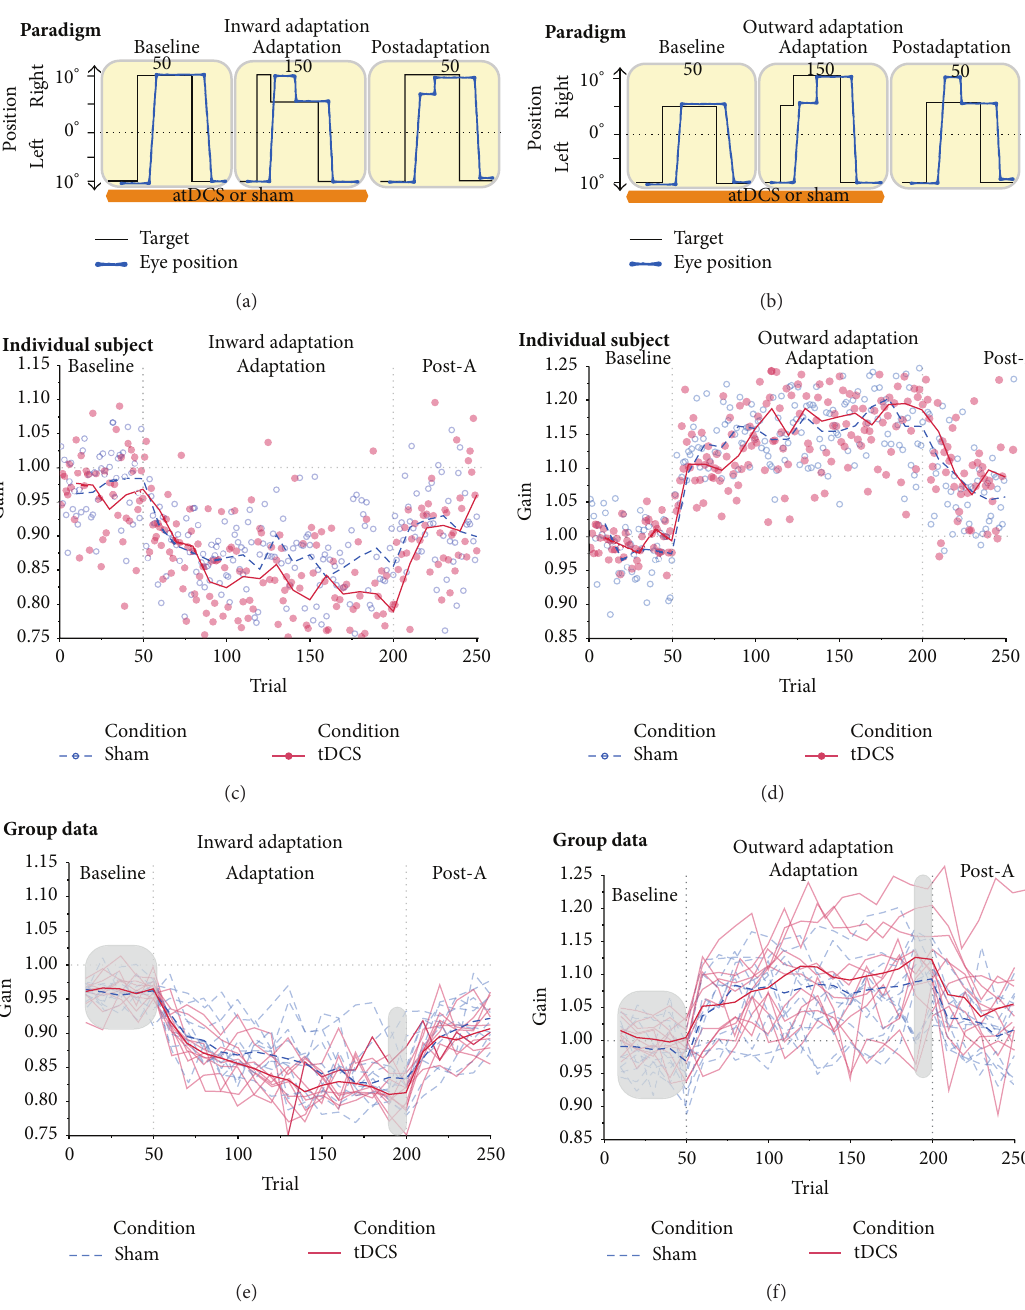
Figure 1: Experimental paradigms, single subject data, and population data. Panel (a) depicts inward adaptation where subjects performed an inward paradigm that consisted of 50 baseline trials of 20 ∘ saccades at intervals between 1.5 and 2 s, followed by 150 adaptation trials where the second target had an intrasaccadic step of 5 ∘ . Eye trace shows an overshoot at the beginning of the phase and the subject makes a corrective saccade to the target. Finally, 50 postadaptation trials presented in the same way as baseline trials. Anodal tDCS was delivered for 15min at the start of the experiment or for 30 s in the sham condition. Panel (b) shows outward adaptation consisting in the same trial structure as inward, but here the subjects experienced baseline trials of 15 ∘ saccades and a forward jump of 5 ∘ (in the direction of the saccade). The middle row shows examples of adaptation for a single subject in the inward adaptation (gain-decrease, panel (c)) and outward adaptation (gain-increase, panel (d)) experiment for the two tDCS conditions. Lines on the top depict blocks composed of the median values of 10 trials. The bottom row shows group data for inward (panel (e)) and outward (panel (f)) adaptation. Thin, low-opacity lines show the course of adaptation for all subjects. Thick lines on the top show the median value for all of the subjects for both paradigms in the two stimulation conditions. For the inward adaptation experiment no differences were observed in baseline or postadaptation phases but presented a significantly smaller gain under cerebellar tDCS condition ( 𝑃 = 0.02 ). In the outward adaptation experiment, subjects also presented a normal course of adaptation in which subjects in the sham condition present relatively smaller gains compared to tDCS condition observed since the baseline phase, though this was not significant in any of the three phases (see Section 3). Gray bars show the measures taken into account for the analysis in this study. (atDCS: anodal transcranial direct current stimulation. Post-A: postadaptation. Blue: sham, red: